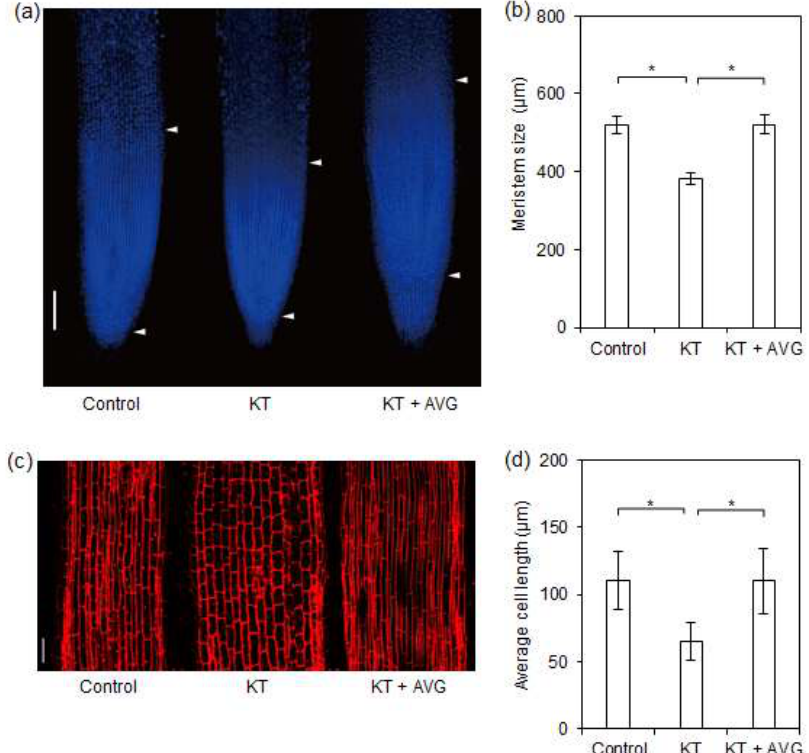
Figure 4. Mitigating effects of AVG on KT-reduced meristem size and cell length in rice seminal roots. Germinated rice seeds were incubated with a solution of KT, KT + AVG, or distilled water as a control. ( a , b ) Mitigating effects of AVG on KT-reduced seminal root meristem size in rice. After 4 days of growth in experimental conditions, the meristem sizes of rice seminal roots were measured using 4’,6-diamidino-2-phenylindole staining. ( c , d ) Mitigating effects of AVG on KT-reduced cell length in the differentiation zones of rice seminal roots. After 4 days of growth in experimental conditions, the lengths of cells in the differentiation zones of rice seminal roots were measured using propidium iodide staining. Bars = 100 µ m for ( a ) and 50 µ m for ( c ). Data are presented as means ± SE calculated from nine biological replicates and significant differences ( p < 0.05) are indicated by asterisks. KT, treatment of 40 nM KT; KT + AVG, treatment of 40 nM KT plus 50 nM AVG.